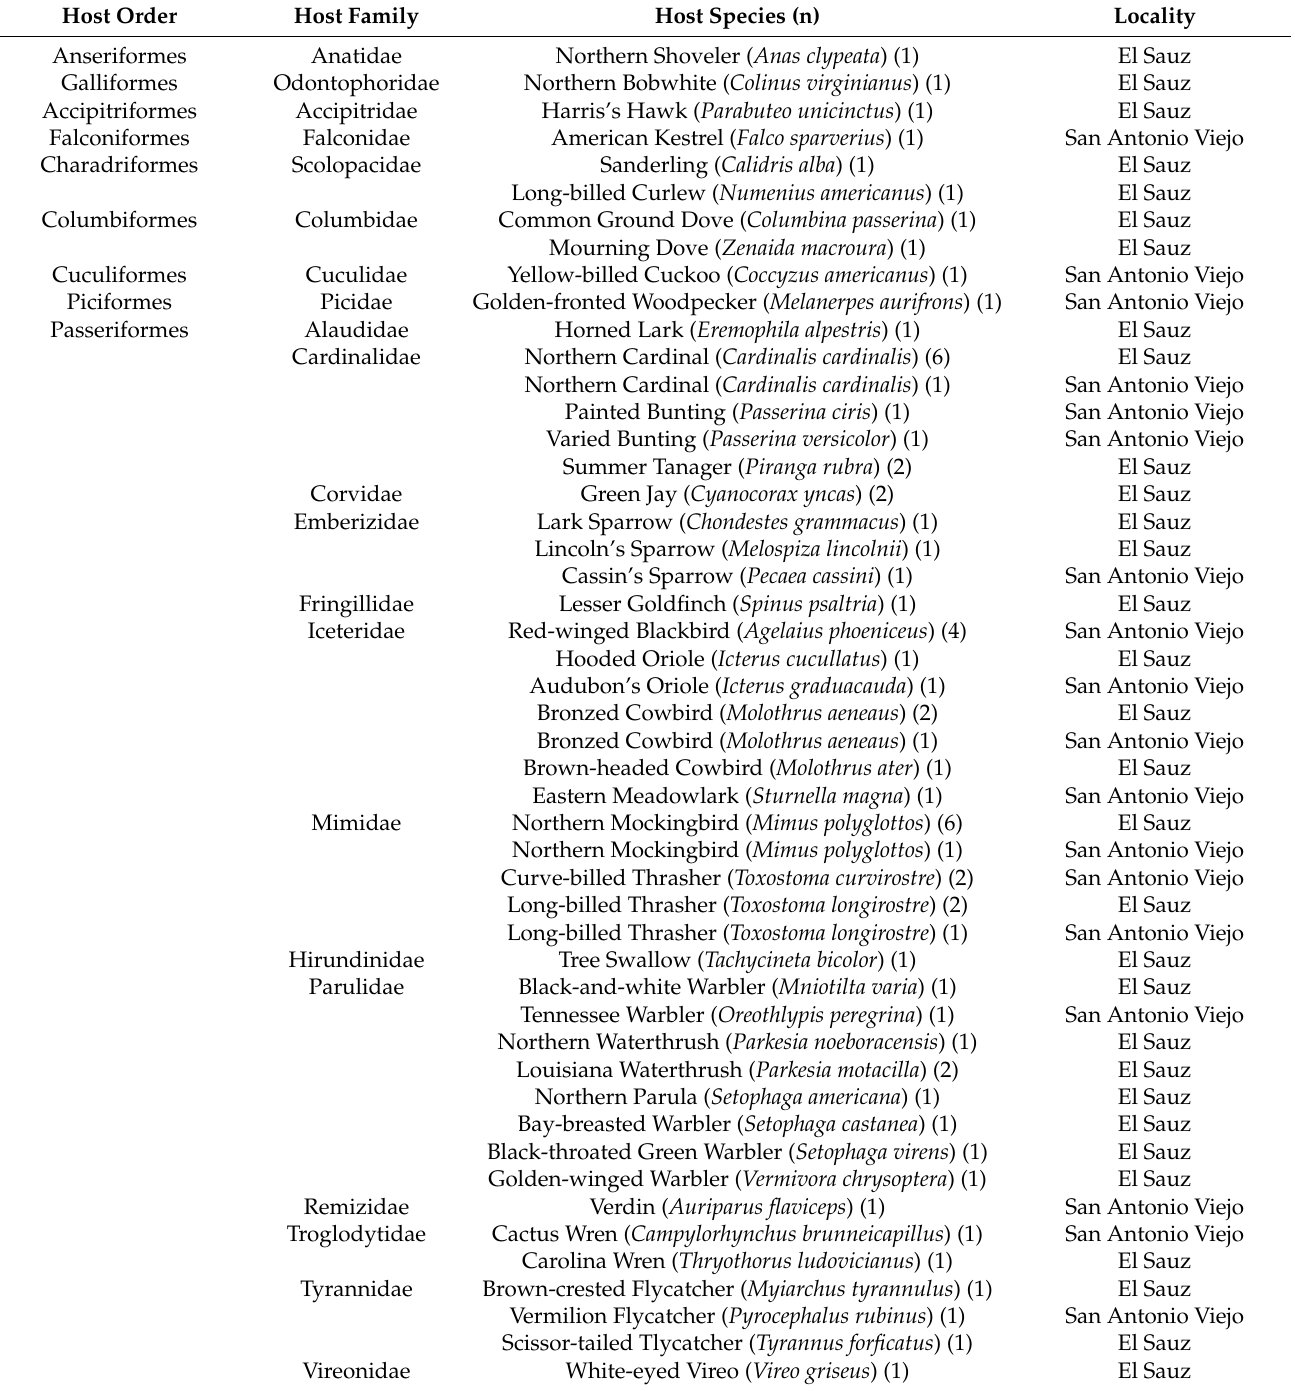
Table 1. Species of birds that were parasitized by chewing lice in South Texas from two East Foundation ranches (San Antonio Viejo and El Sauz) during 2013–2015, where (n) is total number of host individuals per species